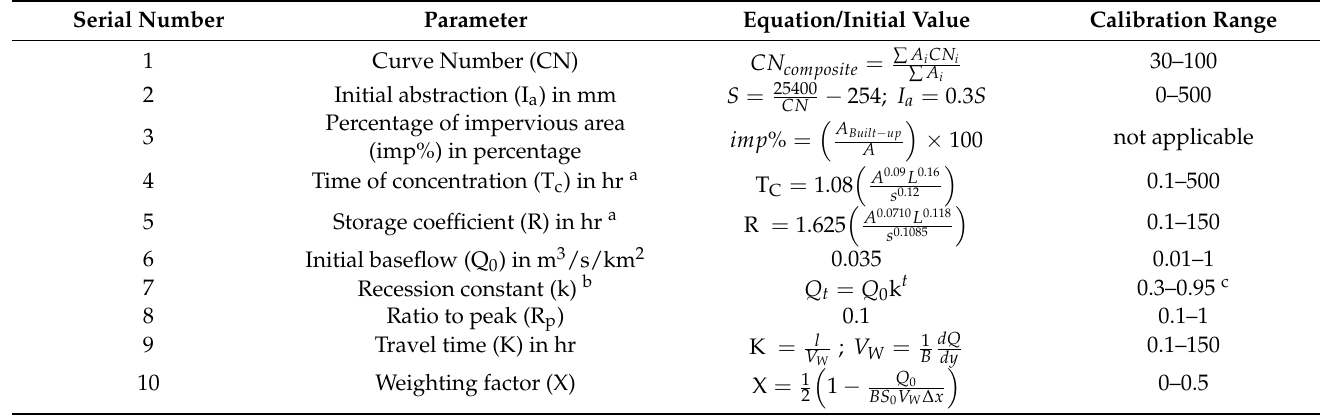
Table 3. List of the HEC-HMS model parameters and empirical equations used to estimate the initial values of parameters along with range of the values used in the